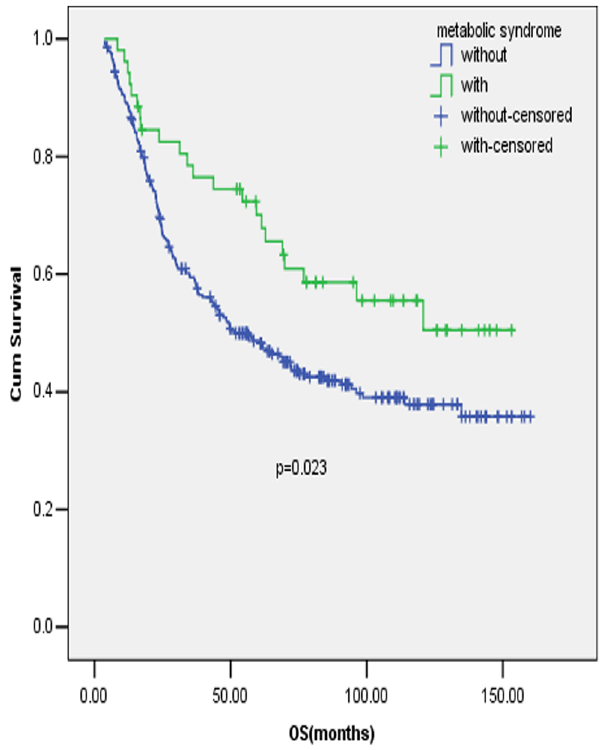
Figure 3. Prognostic value of MetS in early stage gastric cancer patients with proximal tumors. Full legend: Survival curves of early stage GC patients with and without MetS in patients with tumors proximally